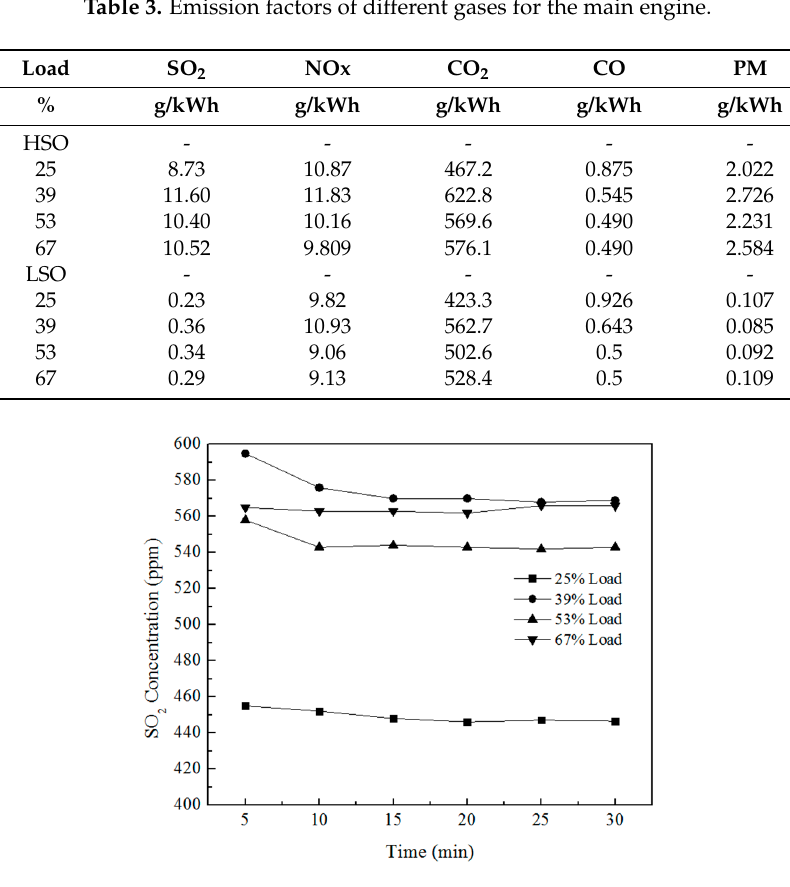
Figure 3. SO 2 concentration with main engine